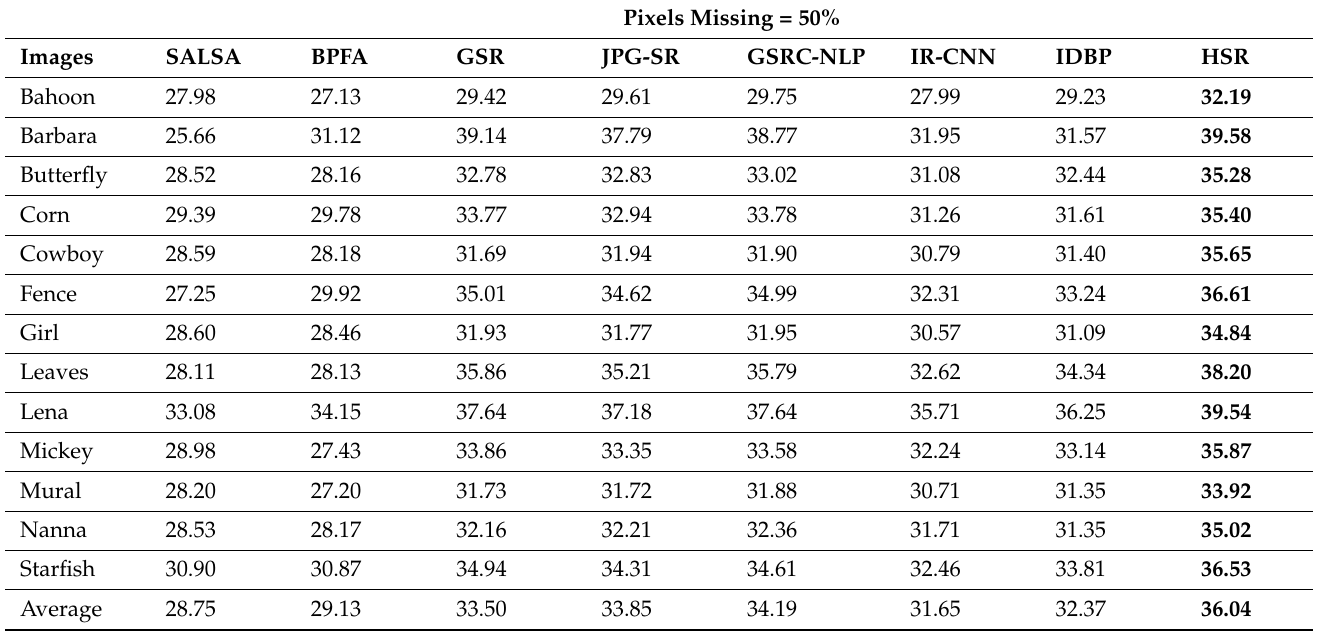
Table 4. PSNR values of our proposed HSR model and other comparison models after image restoration with pixels missing rate